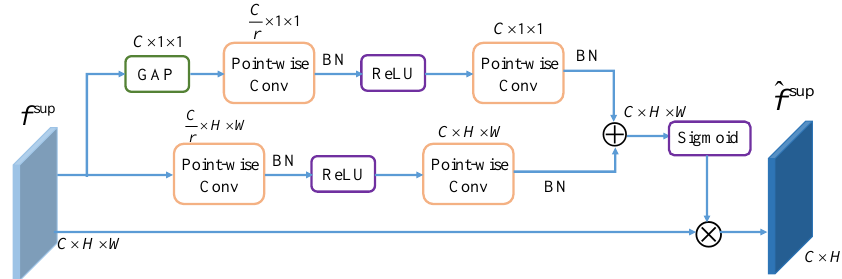
Figure 2. Diagram of our efficient double-branch channel attention (E-DCA)